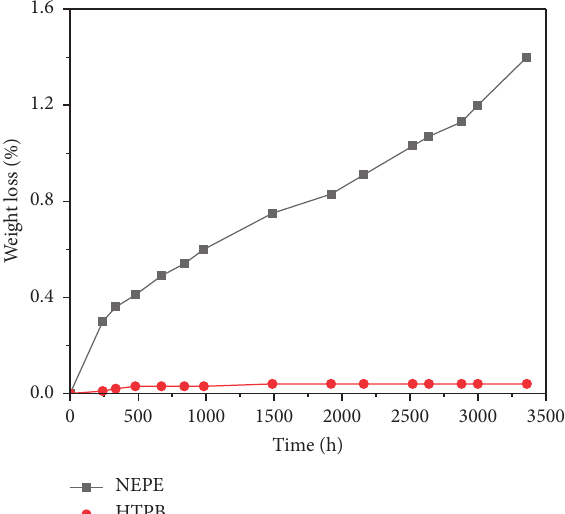
Figure 4: Comparison of the thermal weight loss of the NEPE propellant and hydroxyl-terminated polybutadiene propellant during accelerated storage at 70 ° C.